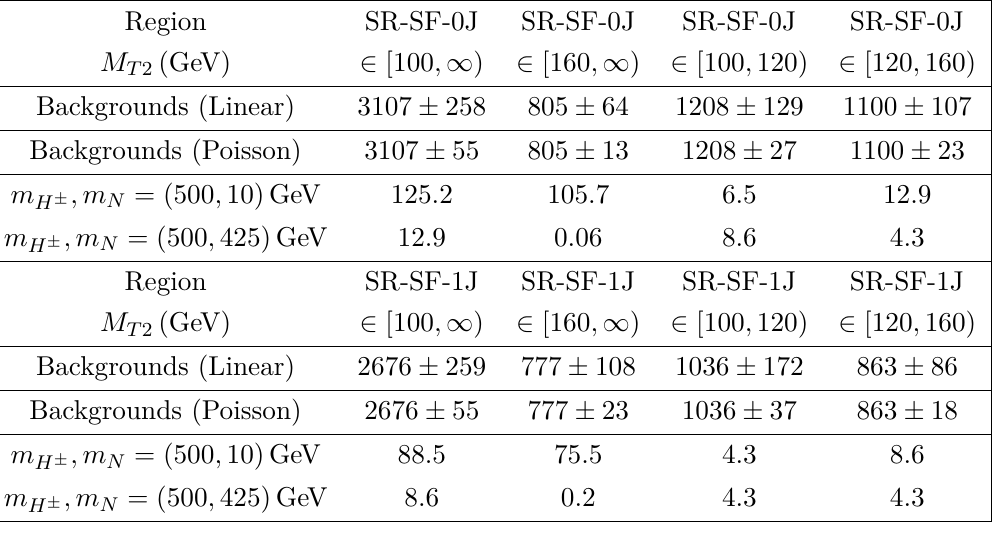
Table 4 . Expected background event yields, at L = 3000 fb − 1 , for the ‘same flavor’ (SF) inclusive signal regions SRs estimated by extrapolating the results in table 3. The uncertainties on the background yields are computed by extrapolating the errors at the LHC they are dominated by systematic uncertainties) or according to a Poisson distribution (assuming they are dominated by statistics). For reference, we show the number of events in the SRs for